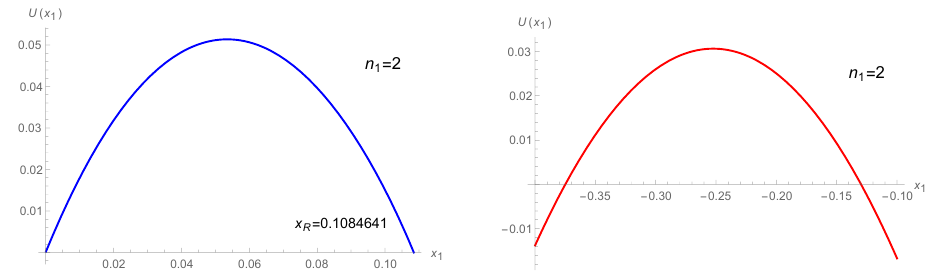
Figure 3 . ( f 0 ; f 1 ; f 2 ; f 3 ; c 1 ; c 2 ; k ) = ( 3 ; 2 ; 3 ; 1 ; 3 ; 0 ; 1) and u 2 = (cid:0) 21 : 32431: the numerical solution 2 (l.h.s.) is distinguished from the polynomial solution